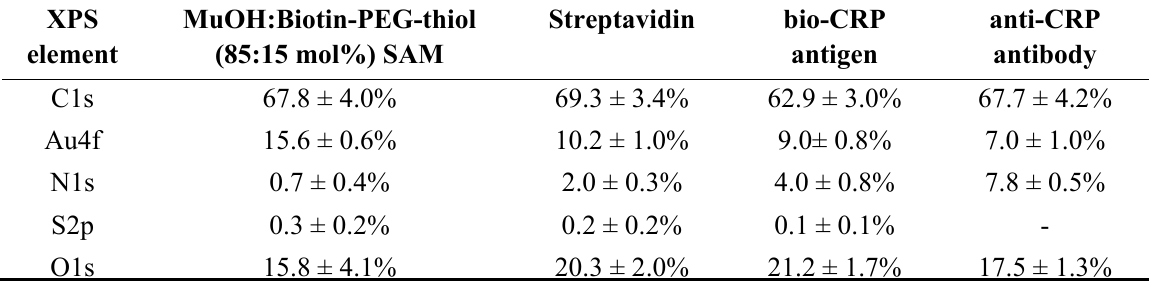
Table 1. Atomic percentages of selected elements after each immobilization step.